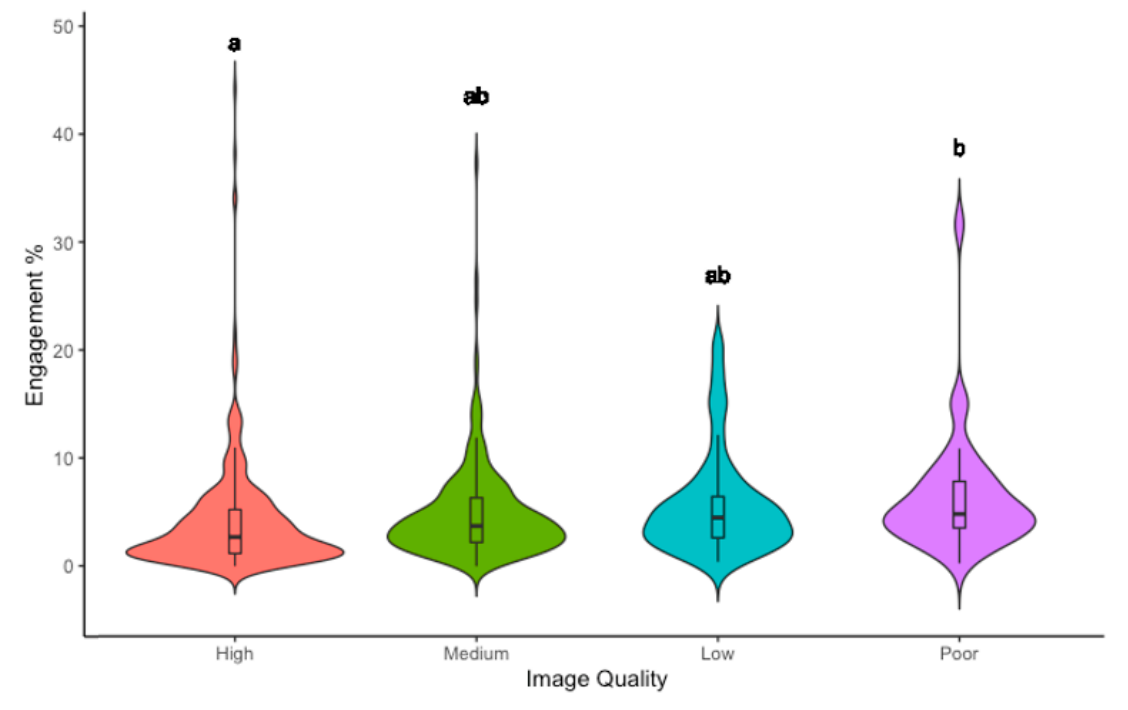
Figure 3. Violin plot with mean and interquartile range (IQR) of the relationship between Image Quality and Engagement (%) for Australian wildlife images posted to Instagram by conservation organisations from 1 January 2020–1 August 2021. Significant differences between categories are denoted by lettering, with the same letter representing no significant difference. Engagement is calculated as the number of likes an image received divided by the account follower count.